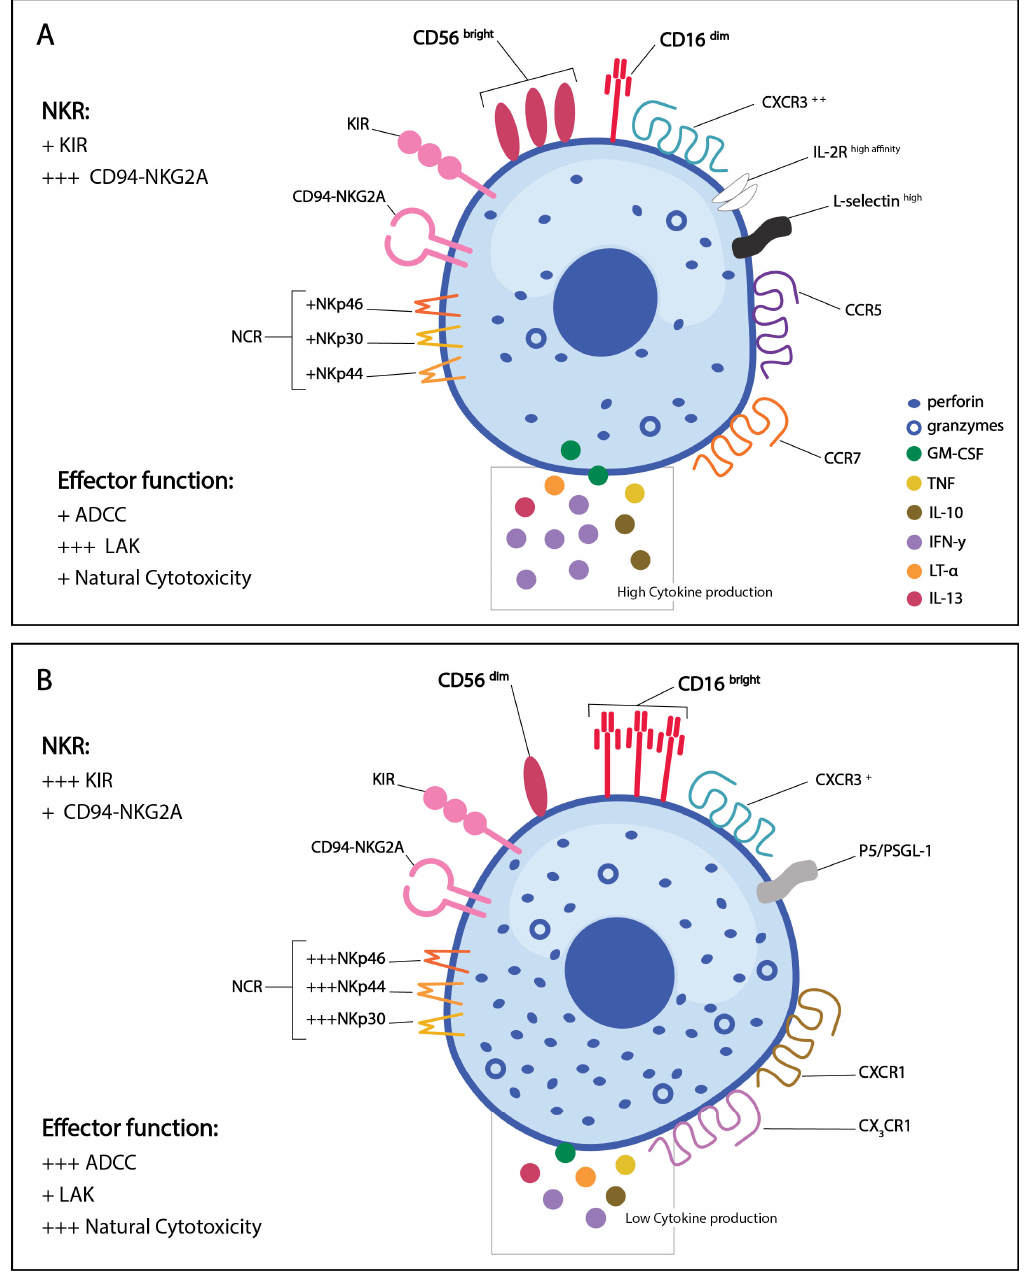
Figure 2. Phenotype of activated human NK cell populations. ( A ) CD56 bright CD16 dim NK cells are functionally higher in cytokine production and lymphokine-activated killer activity, and have low ADCC and natural cytotoxicity. ( B ) CD56 dim CD16 bright NK cells are functionally lower in cytokine production and lymphokine-activated killer cytotoxicity but have high ADCC activity and natural cytotoxicity. + = low expression/functionality, +++ = high expression/functionality. Figure adapted from Cooper et al. [24] .